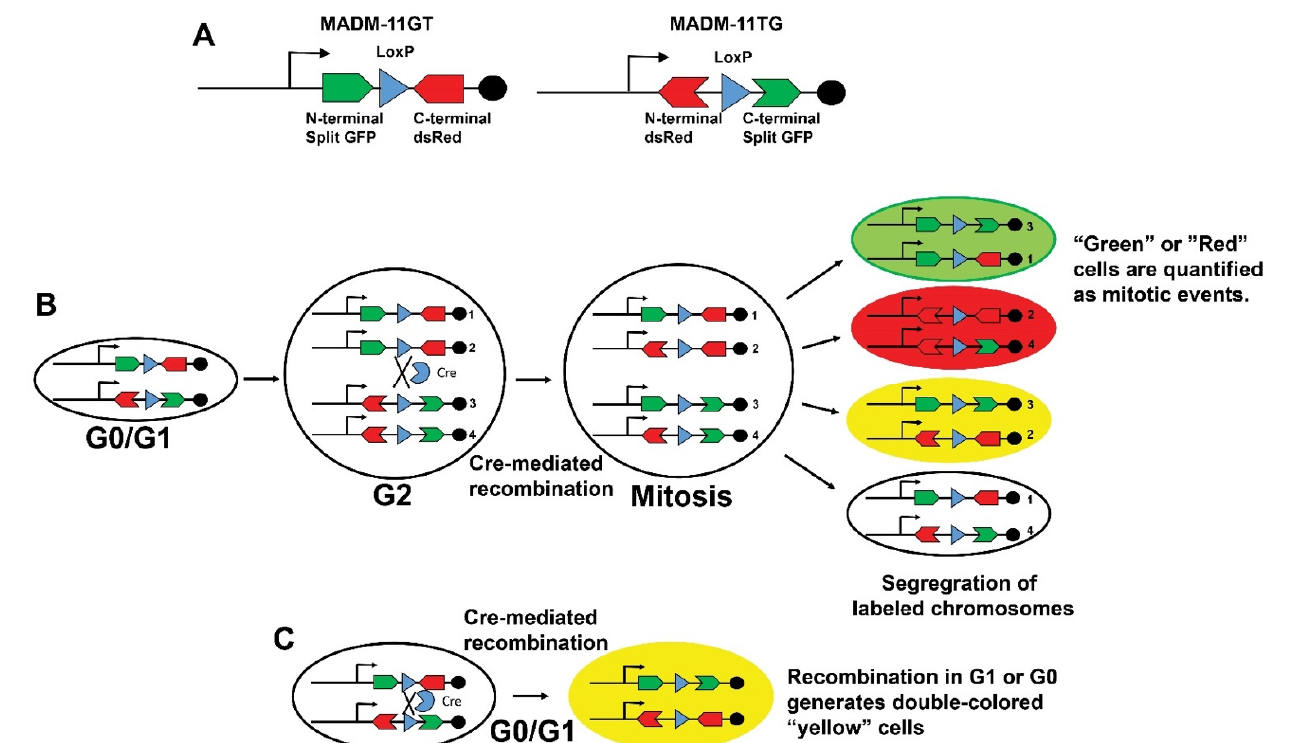
Figure 7. Mosaic Analysis with Double Markers ( MADM ). ( A ) Schematic of MADM-11GT and MADM-11TG transgenes that harbor spilt GFP and dsRed constructs with intronic LoxP sites. ( B ) Tamoxifen exposure induces the Cre recombinase expression that catalyzes an inter-chromosomal rearrangement of split fluorescent reporters and labels mitotic events. ( C ) Recombination during G1 or G1 produces double colored “Yellow” cells. The detection of “Green” or “Red” cells in panel ( B ) allows the quantification of mitotic events. Figure adapted from Zong, H. et al., Cell 2005, 121, 479–492. α MHC-MerDreMer-Ki67p-RoxedCre ( α DKRC ) mice. Advanced non-Cre DNA